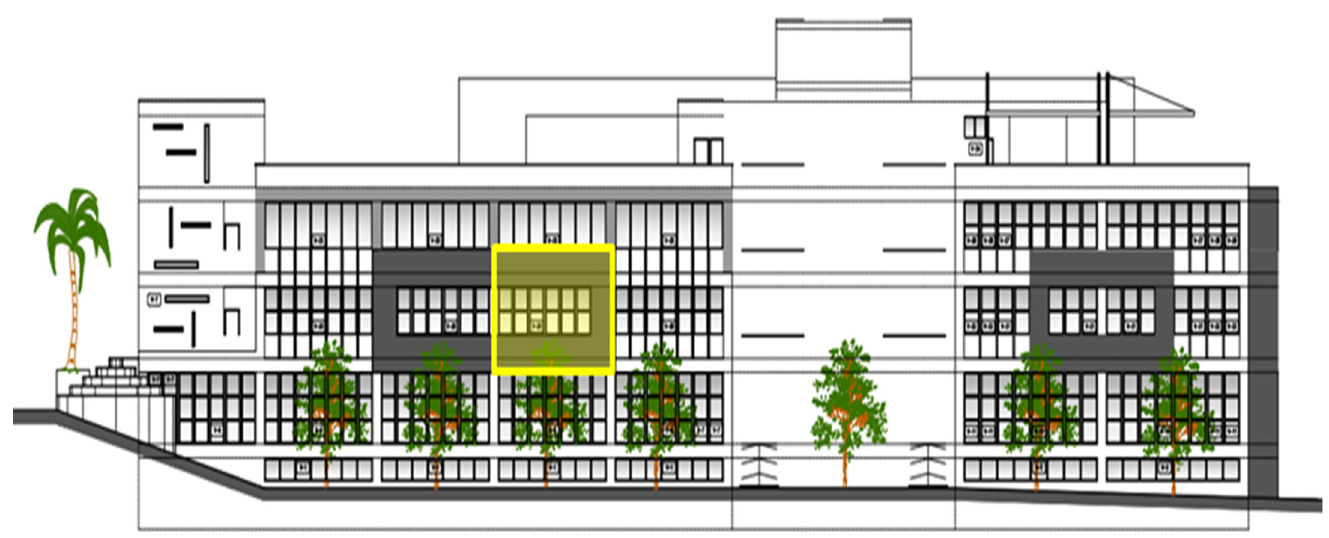
Figure 4. Building front view, Design Laboratory highlighted.